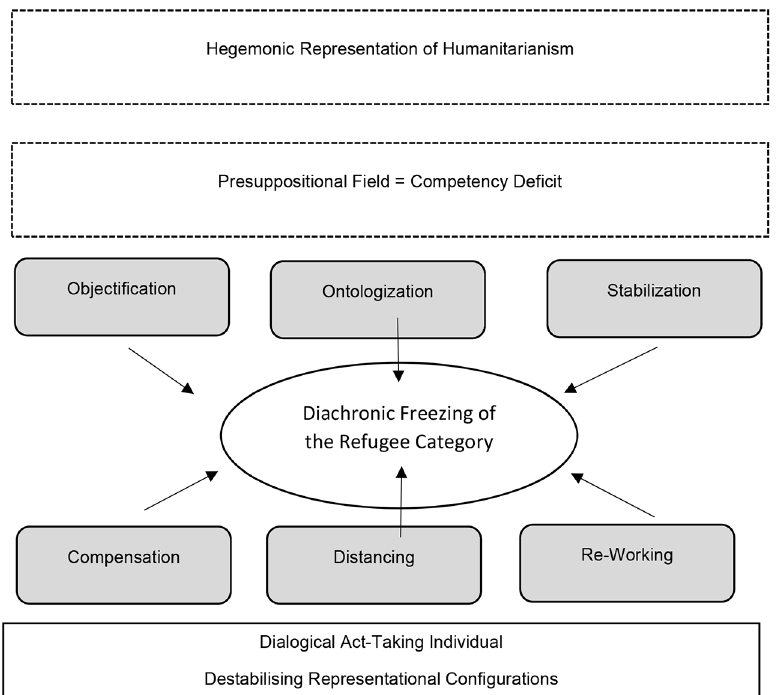
Figure 1. Dialogics of the Refugee Category within encounters in Sweden and the United